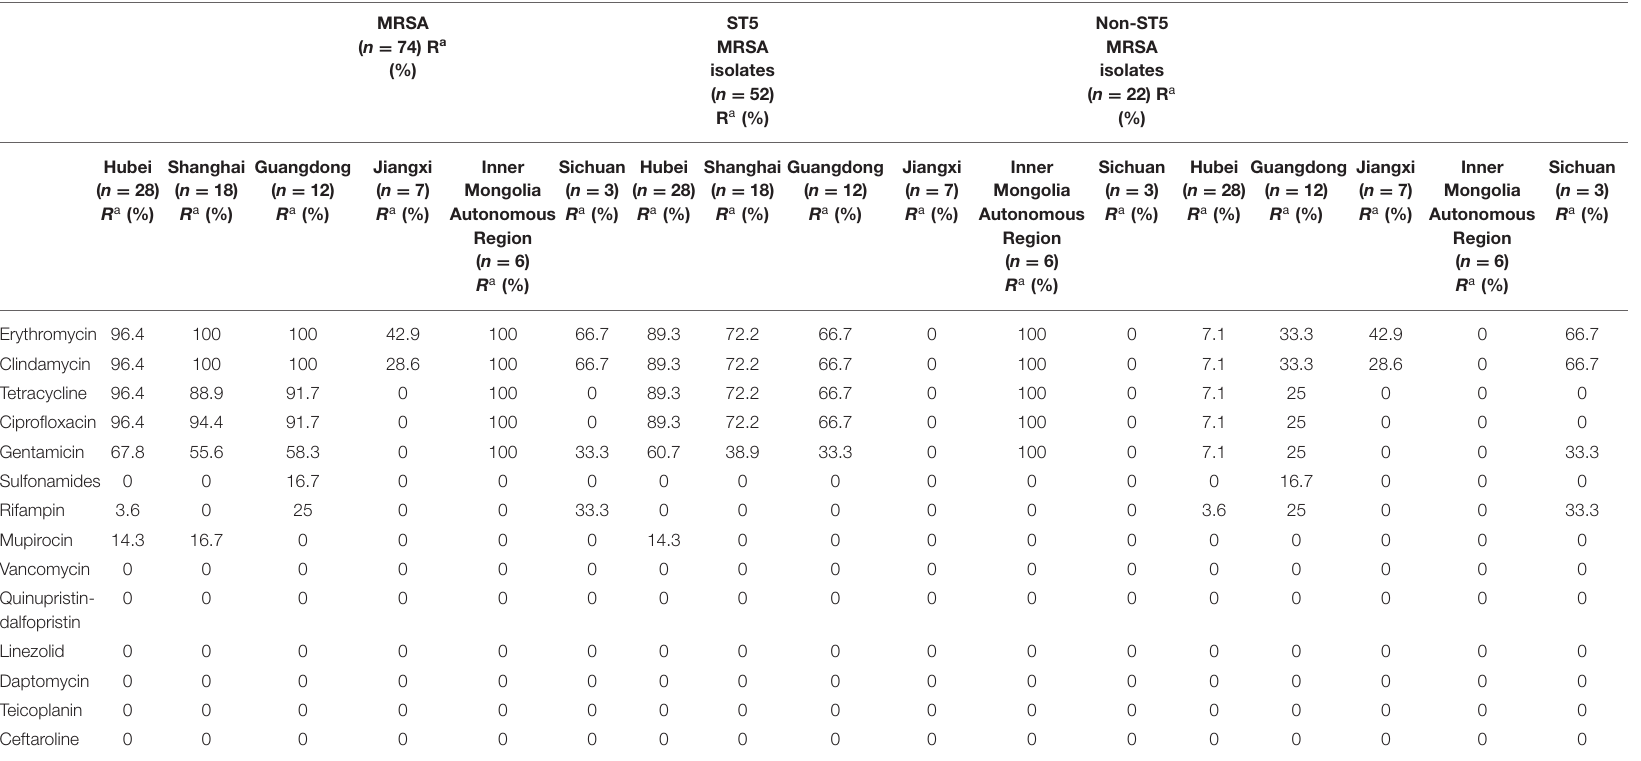
TABLE 1 | Antimicrobial resistance profiles of 74 FA-resistant MRSA isolates, ST5, and non-ST5 MRSA isolates in different regions.